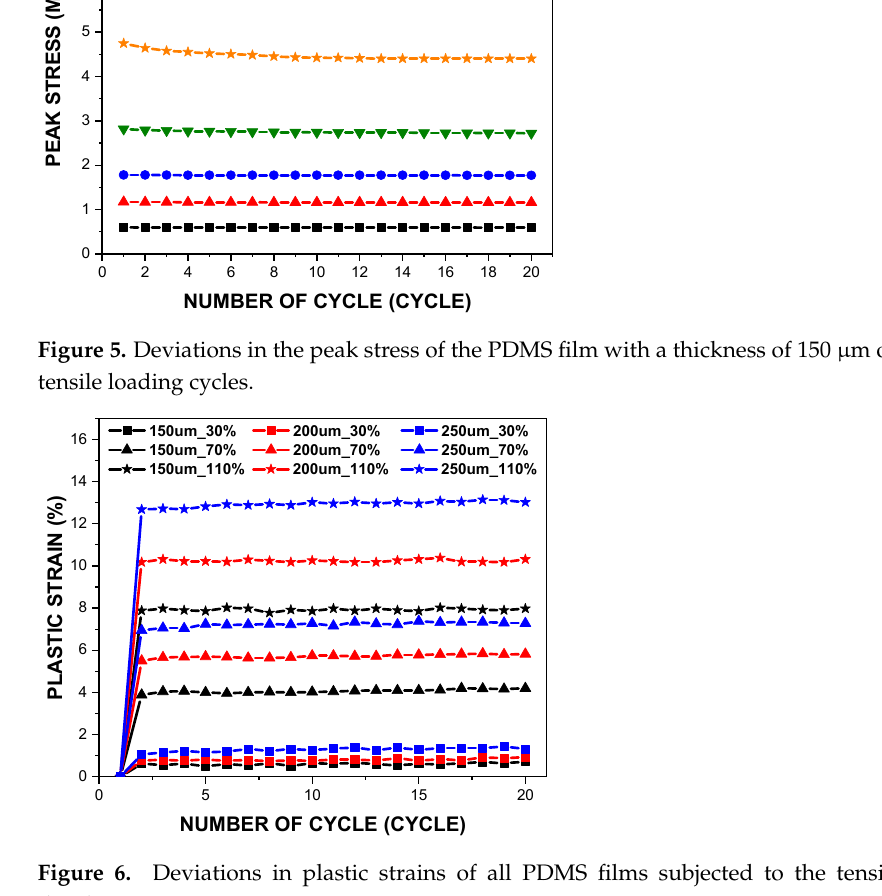
Figure 4. Stress–strain behaviours of the PDMS film with a thickness of 150 μ m at the 1st and the 20th cycle against tensile strain loading; ( a ) 30–70% and ( b ) 90–130%. Figure 5 depicts variations in the peak stress of PDMS film with a thickness of 150 μ m at the 20th loading cycle, at the tensile loading range from 30% to 130%; the results show the stress softening with an increase in the tensile strain loading. The stress softening is a mechanism that occurs when the polymer chain inside the specimen is rearranged by the cyclic tensile behaviour, leading to a change in the stiffness of the specimen [24]. For the range between 30% and 90%, the reduction in the peak stress after the 1st cycle seems very insignificant, but marked decreases were observed for the range between 110% and 130%.